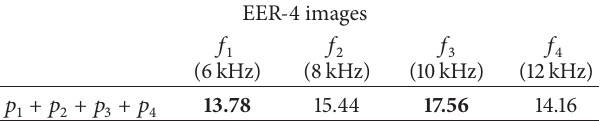
Table 4: Equal error rate using 4 images associated with a position.